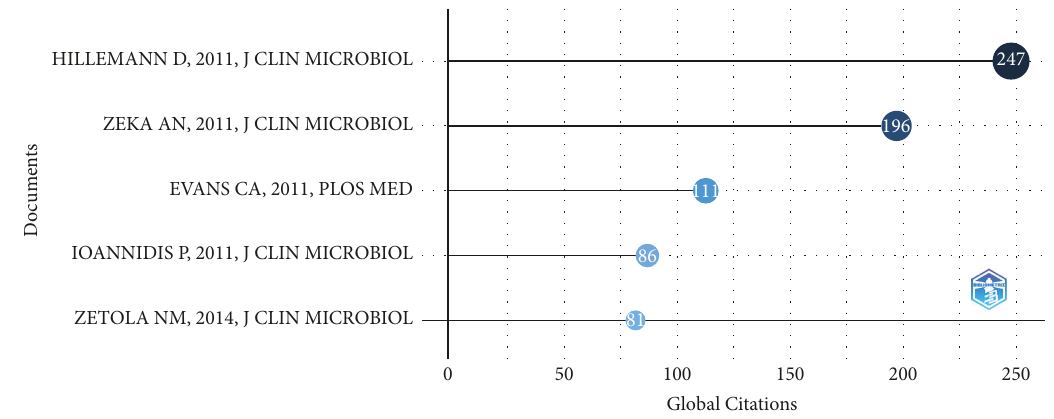
Figure 8: Top 5 most global cited documents on GeneXpert in Table 4: Top 5 of the most local cited references on GeneXpert in tuberculosis.